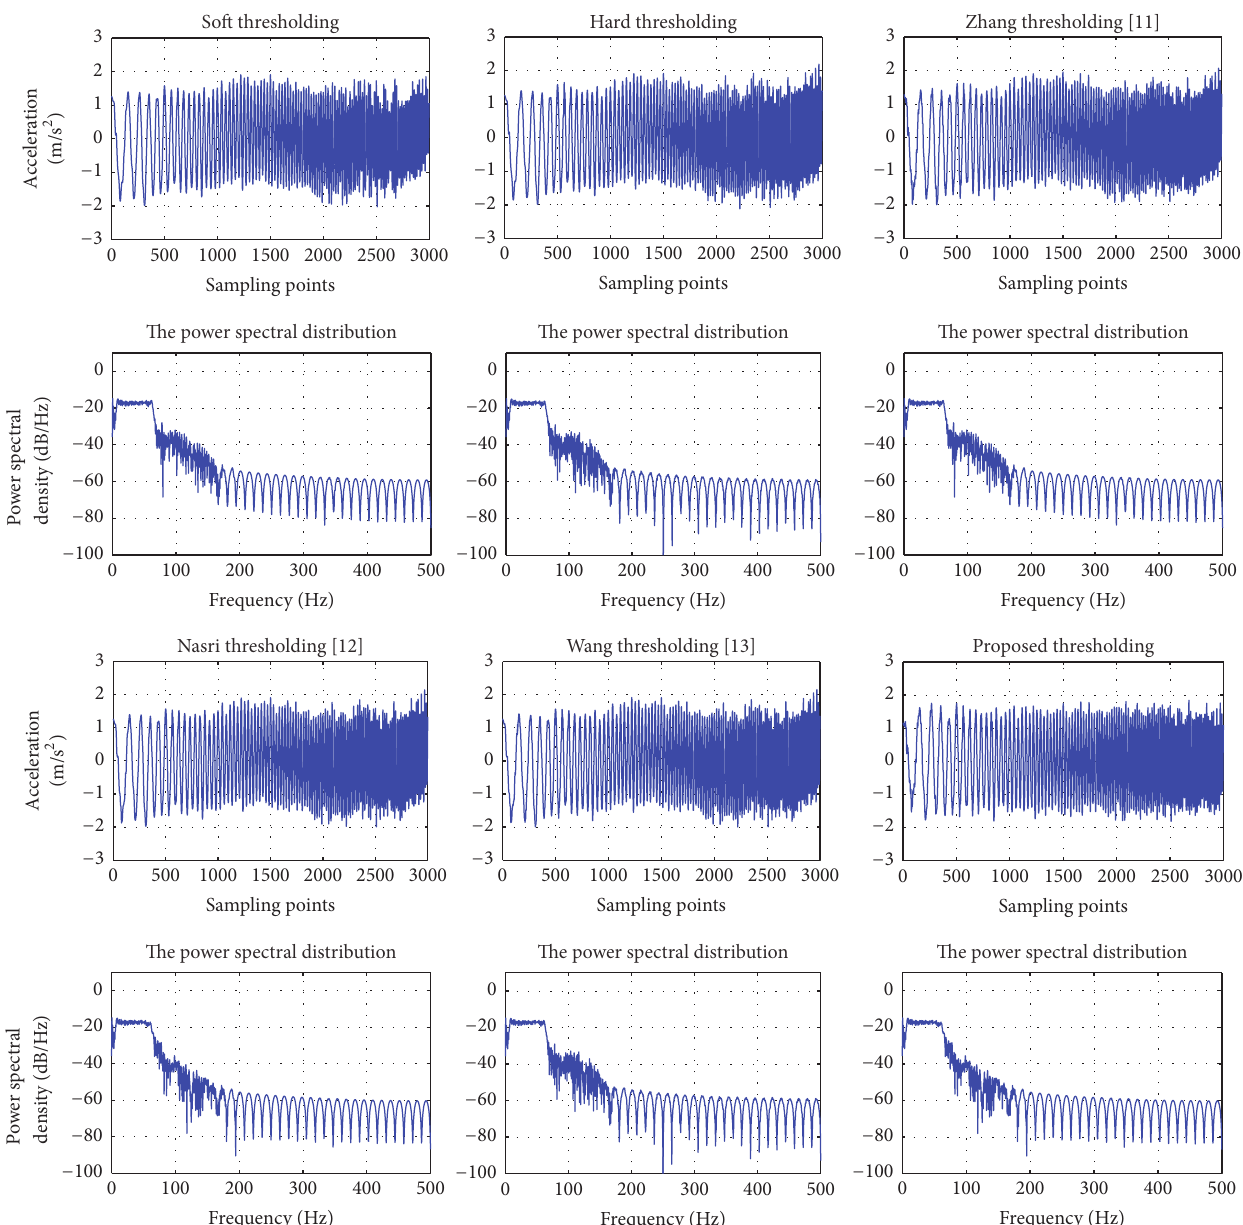
Figure 12: The denoising results of sweep VPVS